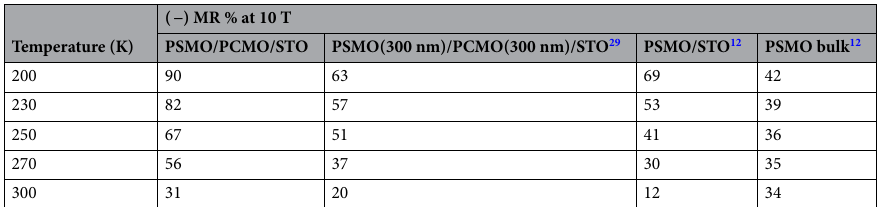
Table 2. Comparison of the MR % of ultra-thin PSMO/PCMO/STO heterostructure with its thicker heterostructure (PSMO(300 nm)/PCMO(300 nm)/STO), PSMO/STO single layer, and PSMO bulk.